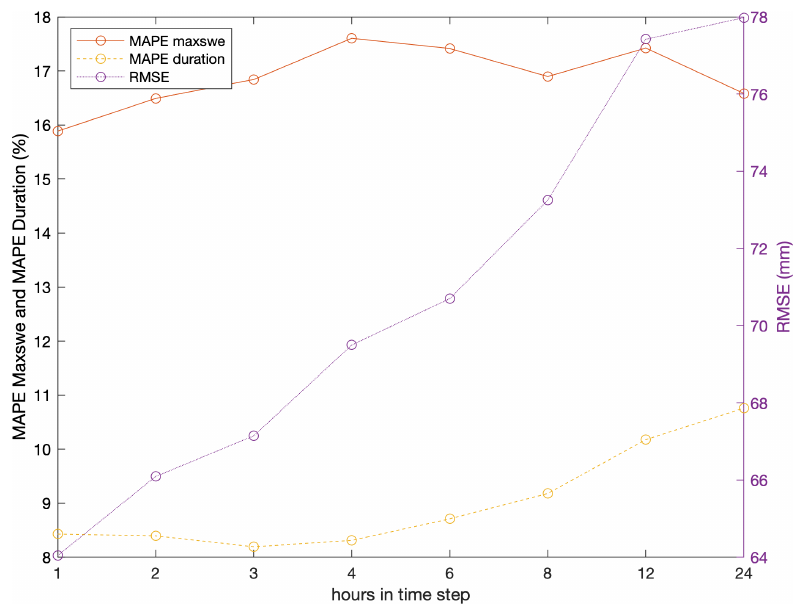
Figure 4. Snow model performance for different time steps using the parameter set selected in calibration of the hourly model. Points represent median values across 170 SNOTEL sites.